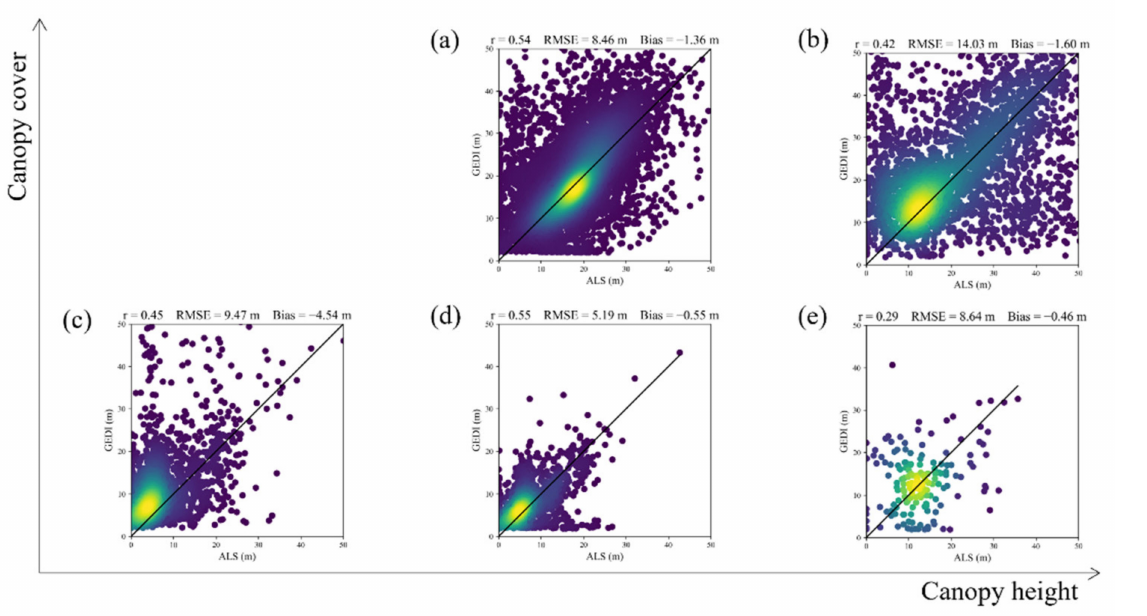
Figure 4. RH95 from GEDI compared to ALS benchmark heights, for eucalypt forests with canopy height/cover: ( a ) Medium/Open, ( b ) Tall/Open, ( c ) Low/Woodland, ( d ) Medium/Woodland, ( e ) Tall/Woodland.